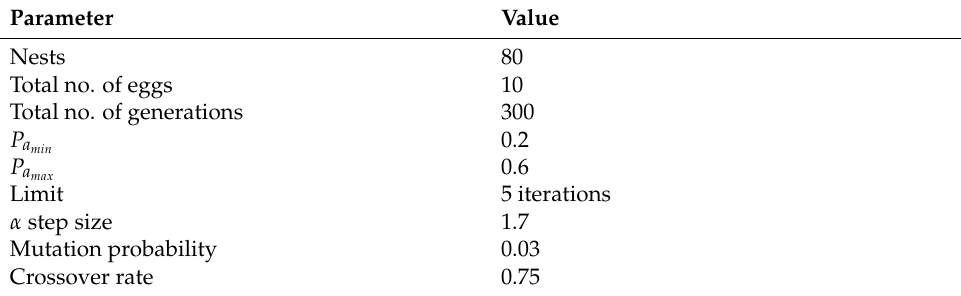
Table 1. Parameter setting of the proposed